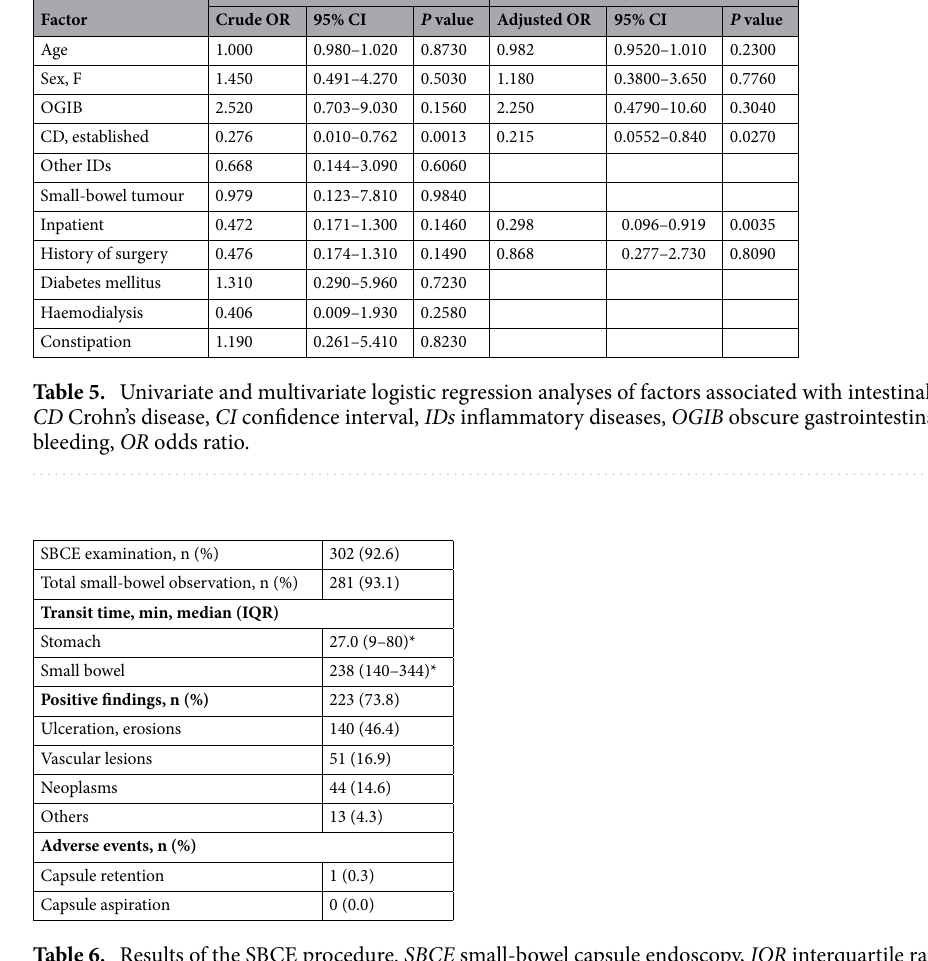
Table 6. Results of the SBCE procedure. SBCE small-bowel capsule endoscopy, IQR interquartile range.